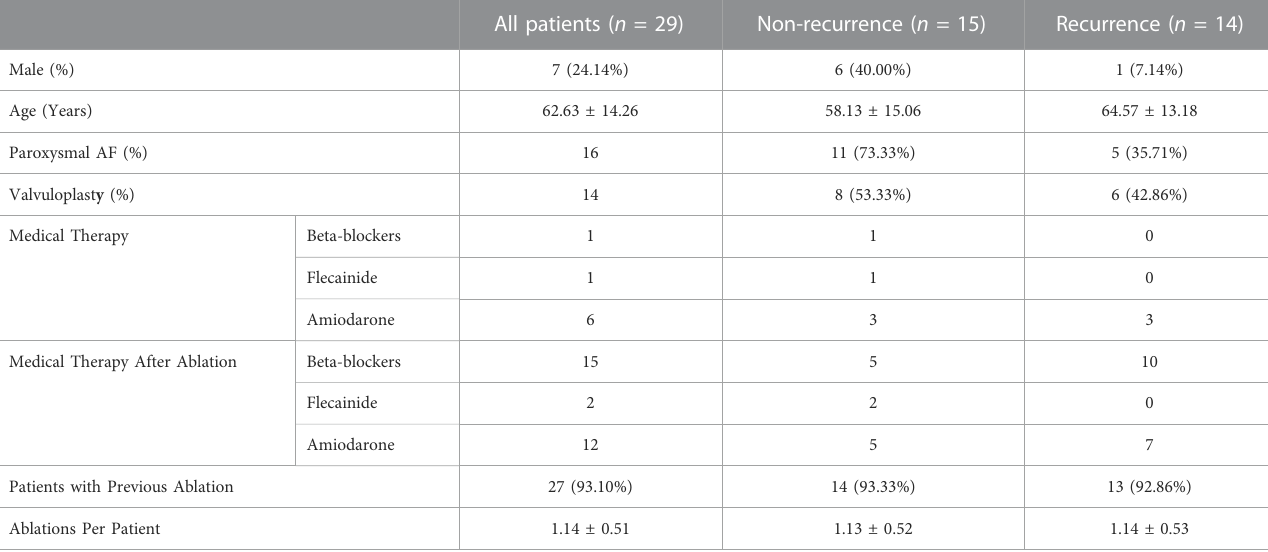
TABLE 1 Description of the population used in the